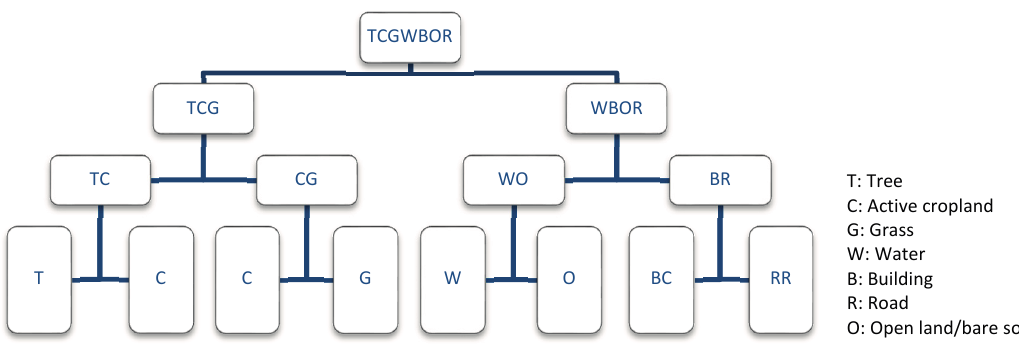
Figure 5. A binary diagram of the object-based rule used in the